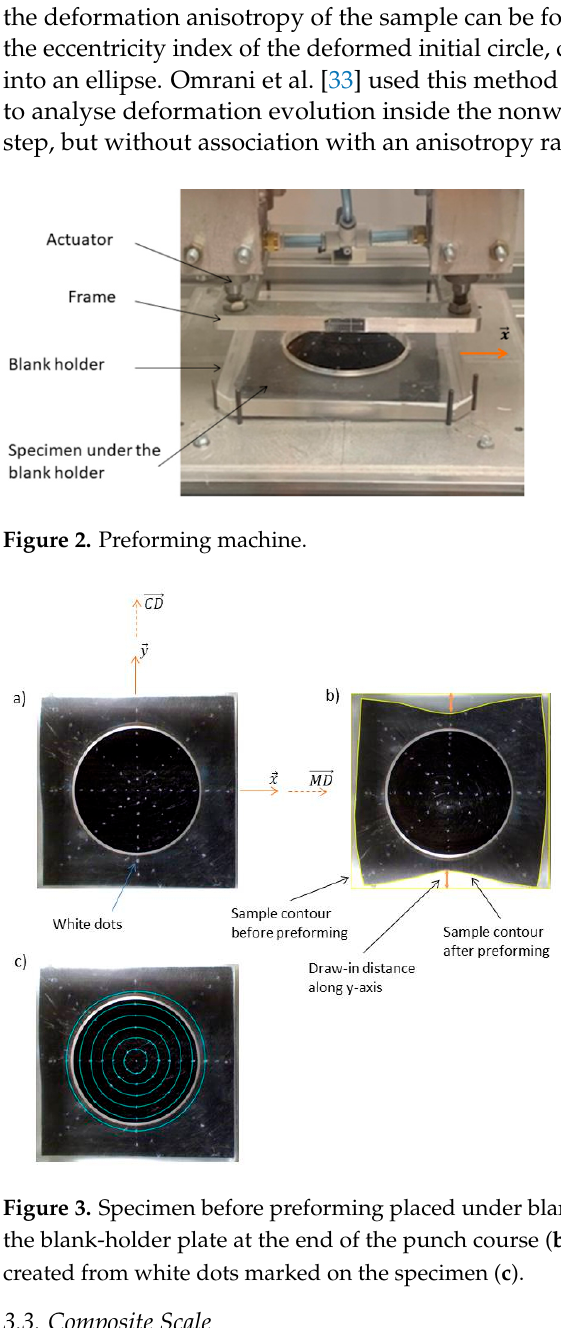
Figure 2. Preforming machine.